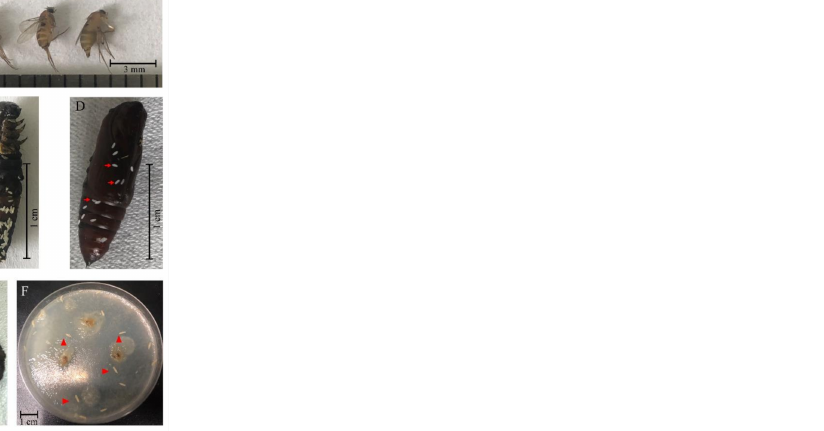
Figure 2. Megaselia scalaris specimens caught in S. frugiperda containers ( A ), S. frugiperda speci- mens with several eggs of M. scalaris ( B – D ), M. scalaris larvae emerging from the S. frugiperda pupa ( E ), and the medium for S. frugiperda intestinal fungi isolation ( F ). ( A – E ) were from Yunnan, and ( F ) originated in Chongqing. Red arrows indicate the eggs of M. scalaris , red triangles indicate the M. scalaris larvae.